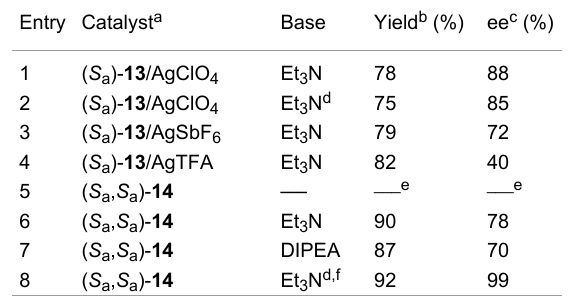
Table 2: Optimization of the 1,3-dipolar cycloaddition of 6a and tert- butyl acrylate using chiral ( S a )-BINAP ( 13 )